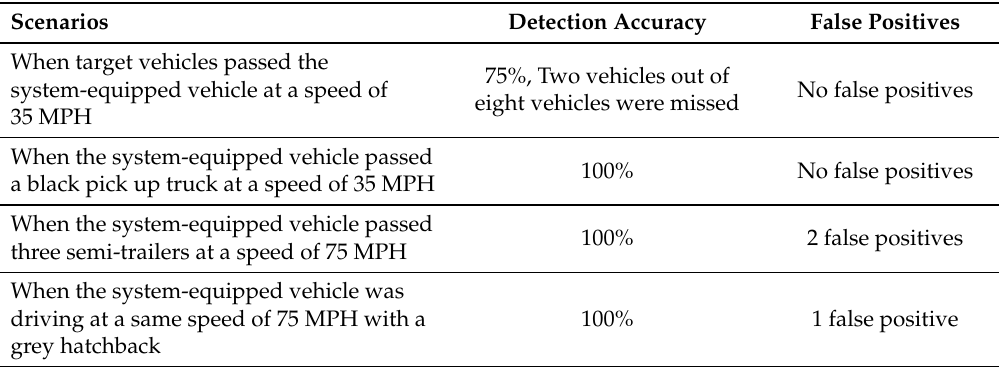
Figure 12. Experimental result of the first testing scenario. Table 3. Summary of experimental results on a real